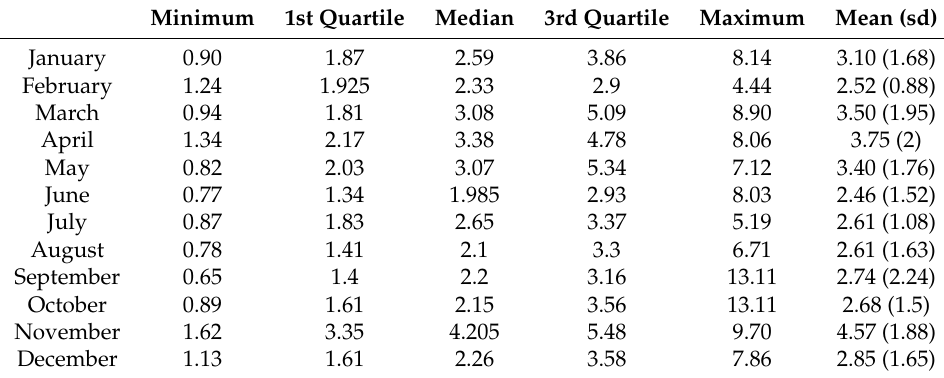
Table 14. Monthly MAPE (in%) for model